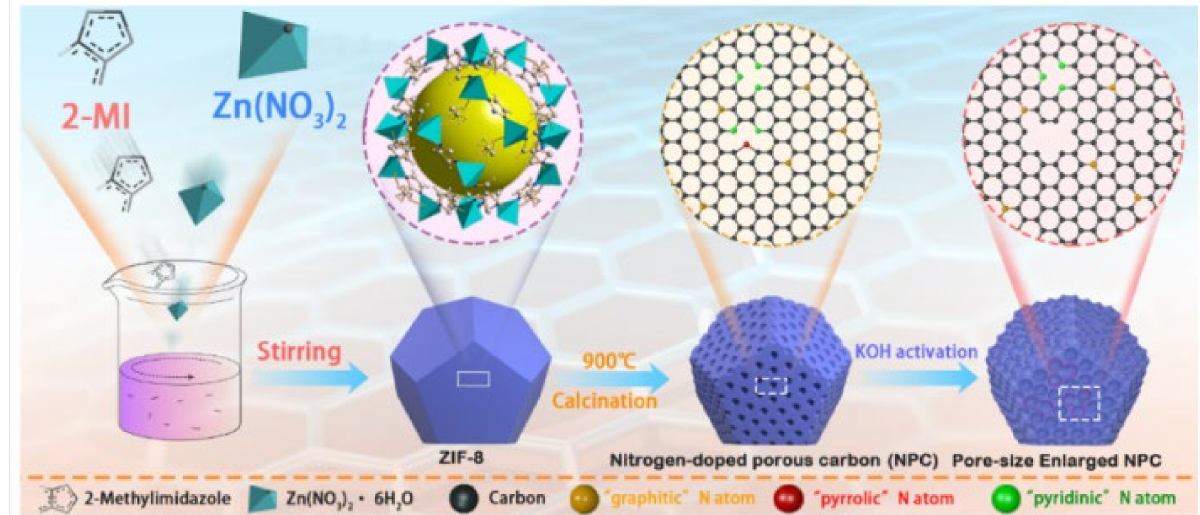
Figure 6. Synthesis of ZIF-8-derived porous carbon and KOH activation for pore enlargement. Reproduced with permission from ref. [75]. Copyright © 2019 American Chemical Society.